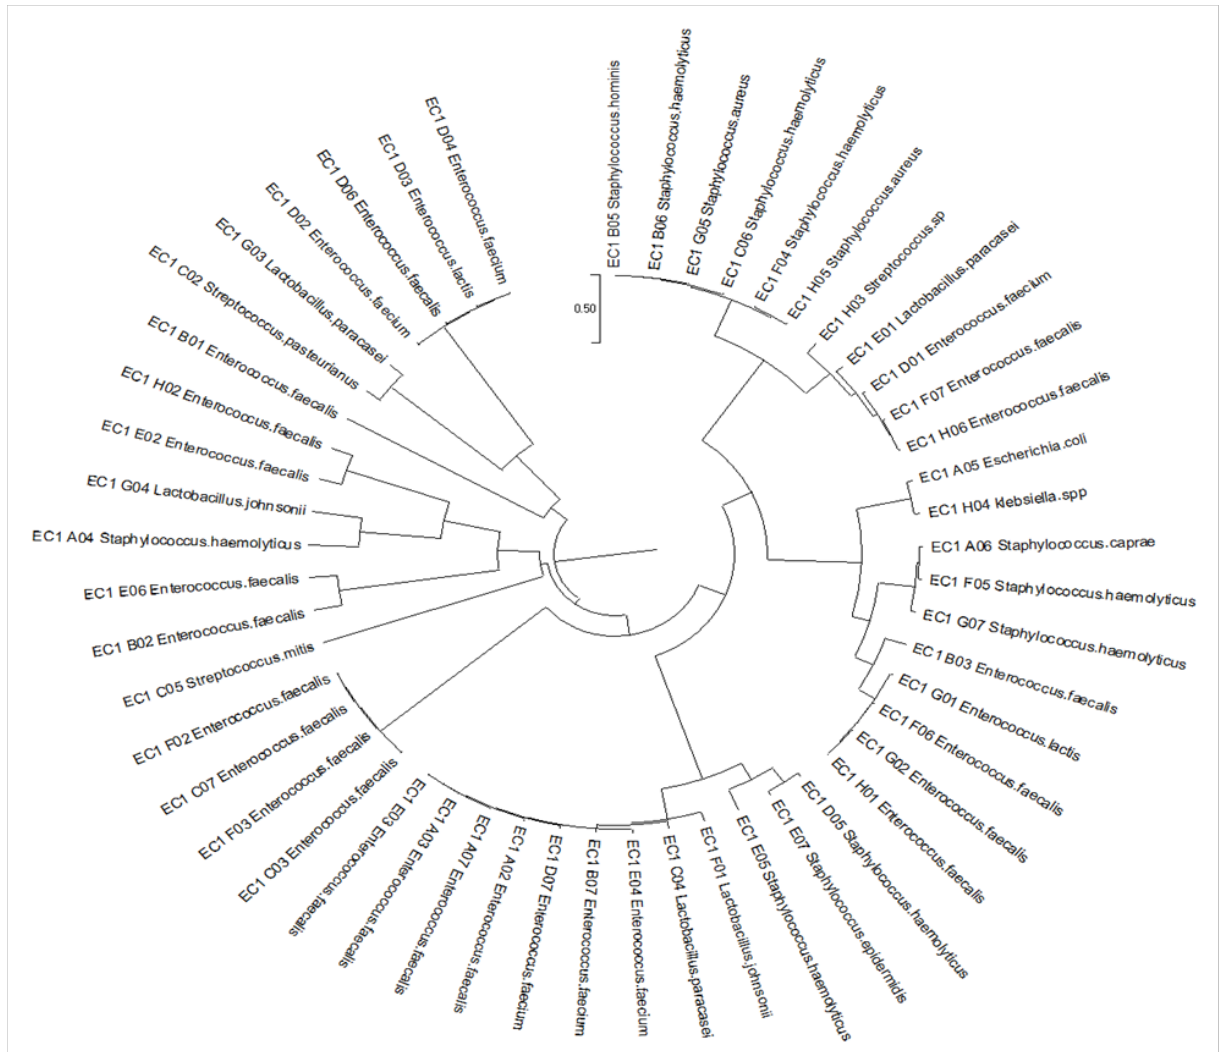
Figure 3. Phylogenetic tree of the isolated strains using UPGMA methods.